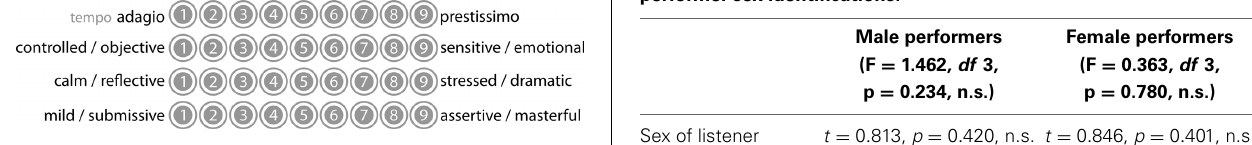
Table 1 | Effects of sex, work-role and age-group of listeners on performer-sex